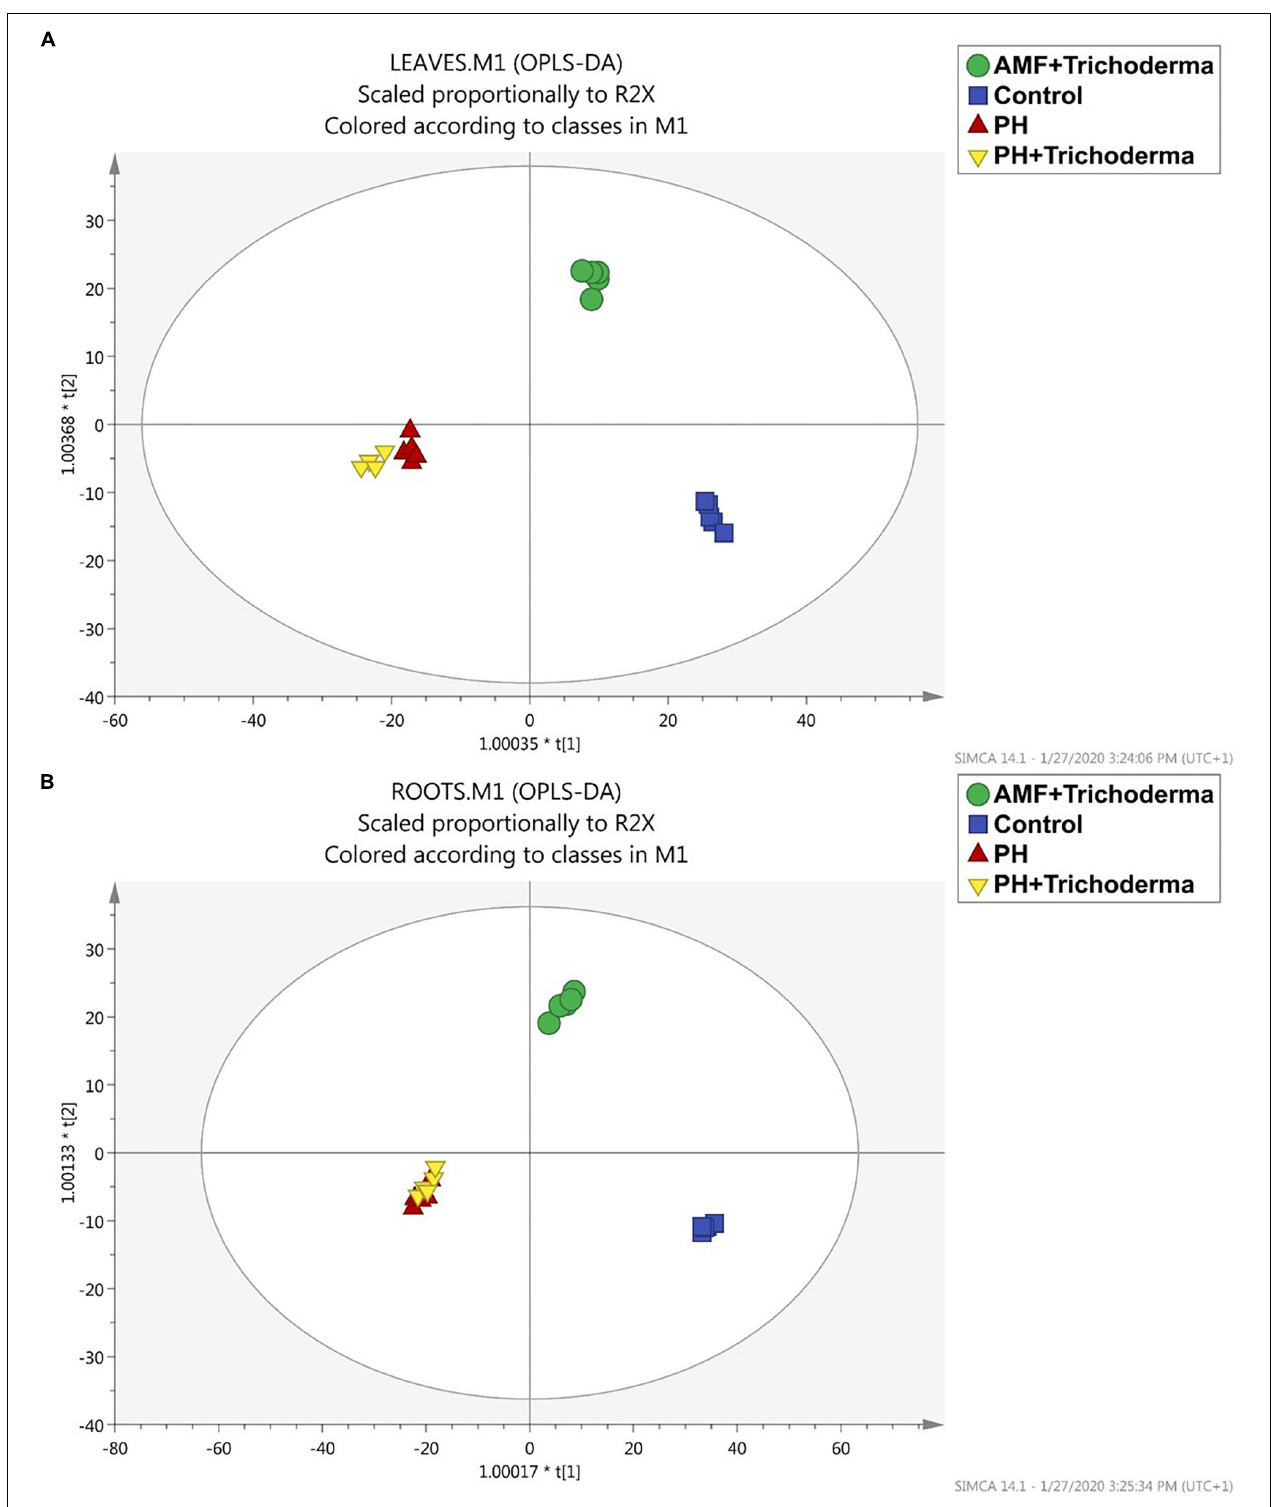
FIGURE 2 | Orthogonal projection to latent structures discriminant analysis (OPLS-DA) supervised modeling of leaves (A) and roots (B) of maize plants treated with a consortium of arbuscular mycorrhizal fungi (AMF), Trichoderma koningii TK7, and rhizosphere bacteria or with a consortium of Trichoderma koningii TK7 and rhizosphere bacteria (Tricho) plus a protein hydrolyzate-based biostimulant (PH), or with a protein hydrolyzate-based biostimulant (PH). The metabolomic dataset produced through UHPLC-ESI/QTOF-MS was Pareto scaled and then used for the multivariate OPLS-DA modeling.